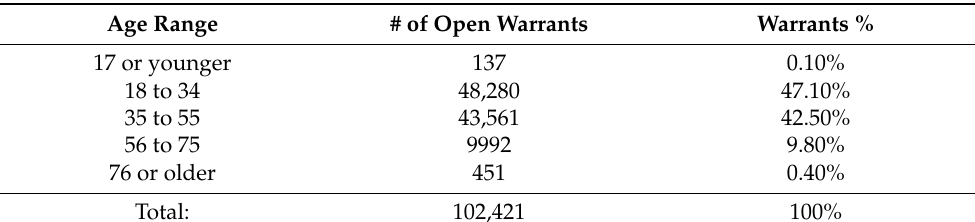
Figure 6. Open Warrants shown by Gender. Table 8. Distribution of Defendants’ Age on Open Warrants.